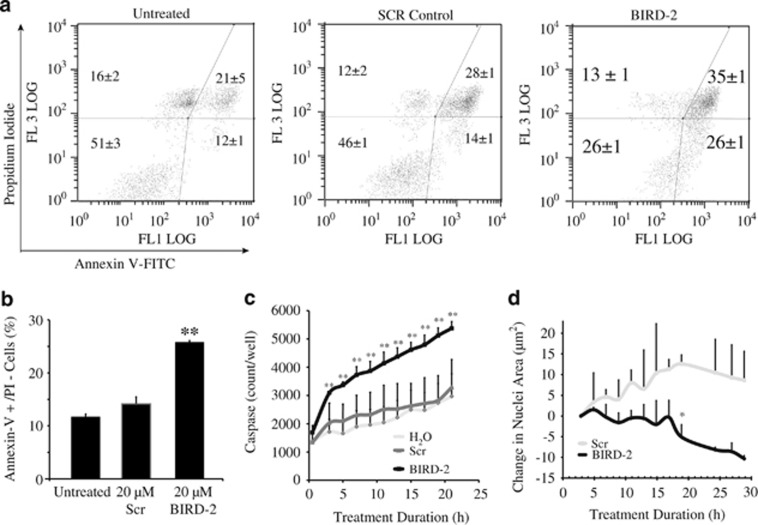
Biochemical evidence of apoptosis induction by BIRD-2. (a) Flow cytometry of Annexin V and propidium iodide–stained H2171 SCLC cells following treatment with 20 μM BIRD-2 or Scr for 1 h. (b) Bar graphs (mean±S.D., three experiments) quantifying the percentage of cells, treated, and analyzed as in panel (a), which are Annexin V positive but propidium iodide negative. (c) Quantification of caspase 3/7 activity in H2171-RFP cells by IncuCyte ZOOM at various time points following addition of 20 μM BIRD-2 or Scr. (d) Measurements of nuclear area in H2171-RFP cells treated as in panel (c). Error bars represent mean±S.D., N≥3 experiments. *P<0.05. **P<0.01